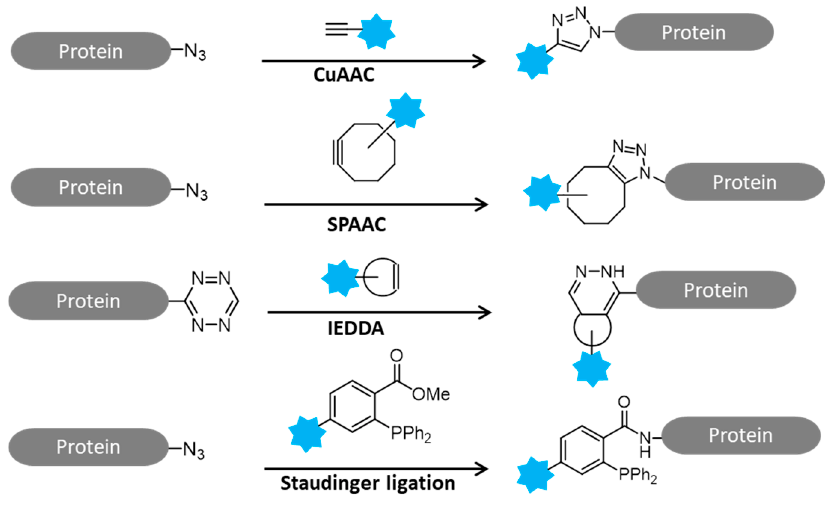
Figure 1. Schematic reactions of click chemistry.